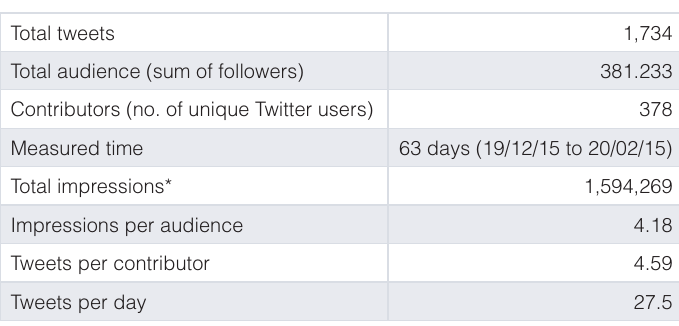
Table 1. Data obtained from the